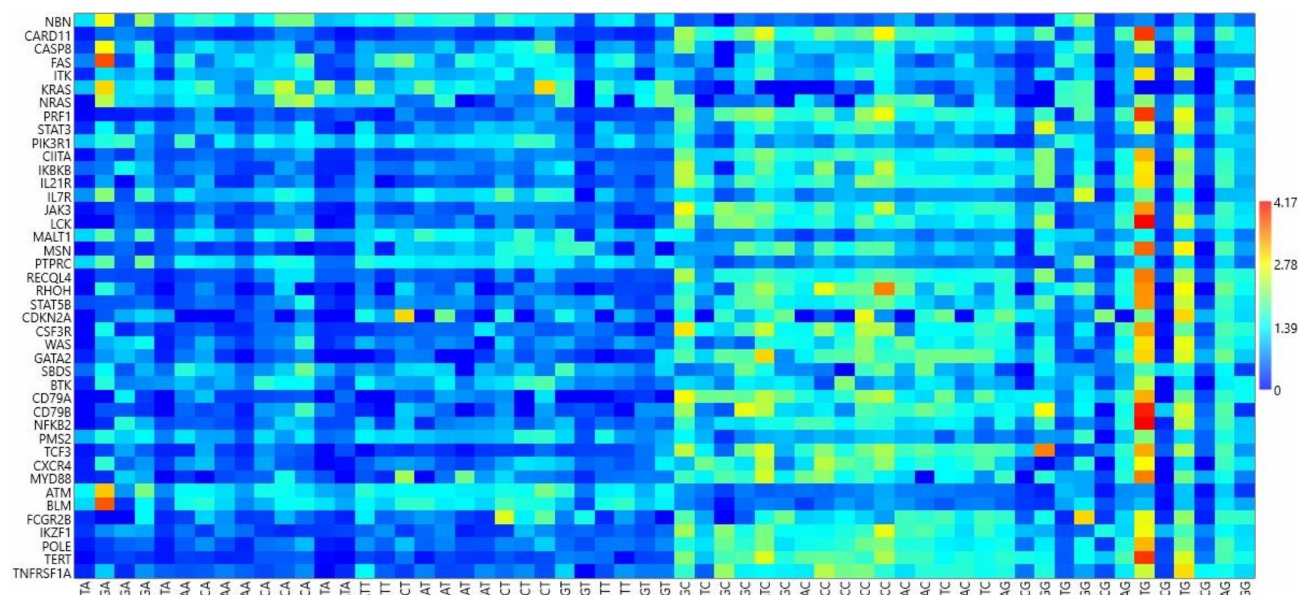
Figure 5. Matrix heat map for RSCU values of codons ending with A, T, G, and G (from right to